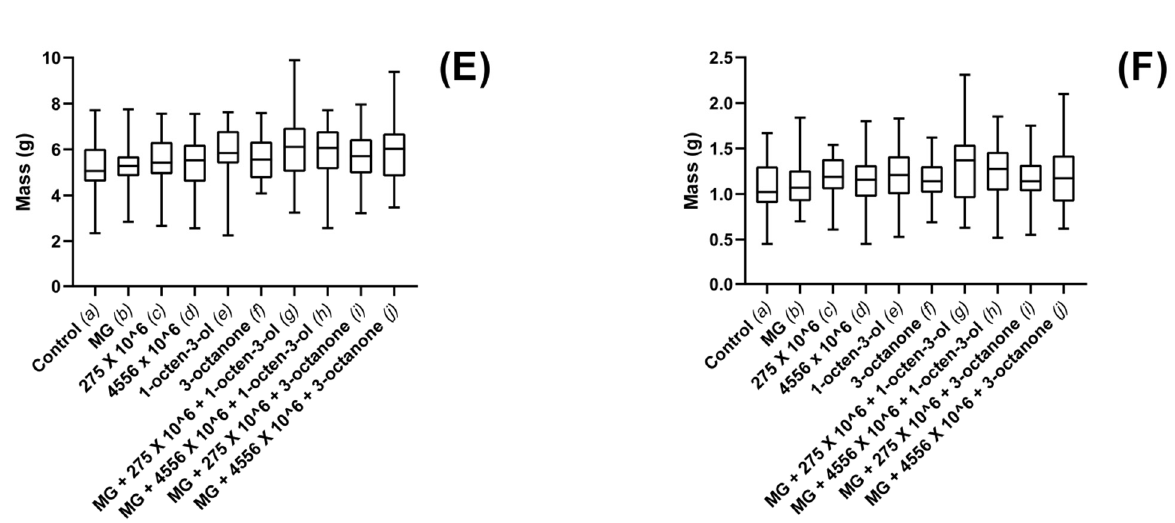
Figure 6. Plant growth metrics for maize plants exposed to M. brunneum , M. brunneum -derived VOCs and hydrogels. ( A ) whole-plant fresh mass, ( B ) whole-plant dry mass, ( C ) fresh shoot mass, ( D ) dry shoot mass ( E ) fresh root mass and ( F ) dry root mass, recordings for plants grown in composts treated with hydrogels (MG), M. brunneum strains: V275 or 4556, 1-octen-3-ol, 3-octanone or combinations thereof. All M. brunneum applications were standardized at 1 × 10 6 conidia g − 1 compost, and all VOCs were added at a rate of 1 µ L 100 g − 1 compost. Hydrogels were added according to manufacturer specification. Controls were grown in untreated composts. Plants were grown in a glasshouse maintained at 25 ± 2 ◦ C for a total of 12 weeks. Controls were exposed to compost media without additional treatment. Figure display’s minimum, 1st quartile, median, 3rd quartile and maximum measurements within the treatment groups. Significant results denoted between treatments using letters ( a – j ) above each boxplot; where denotation letters are absent, no significant differences were detected between treatments. Key: 275— M. brunneum (Strain: